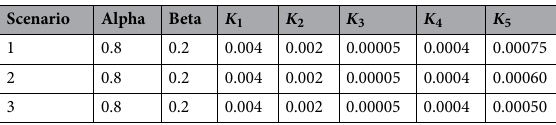
Table 8. BELBIC Controller Parameters.